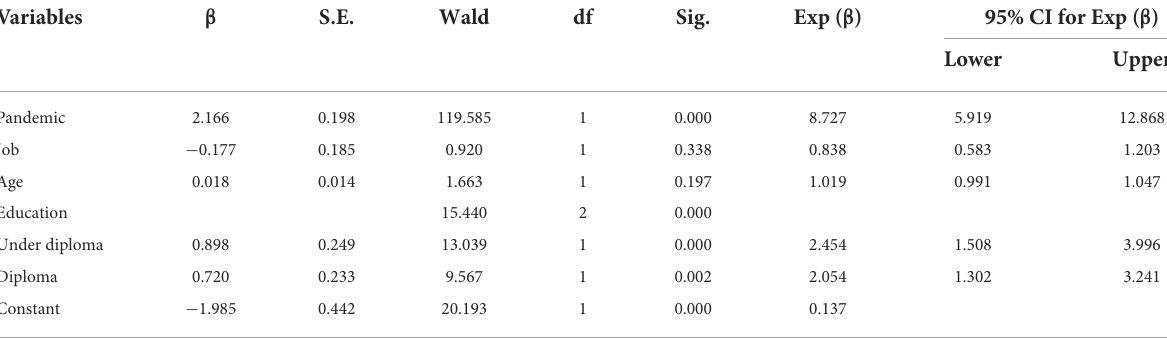
TABLE 3 Logistic regression of the relationship between postpartum depression and COVID-19 pandemic.